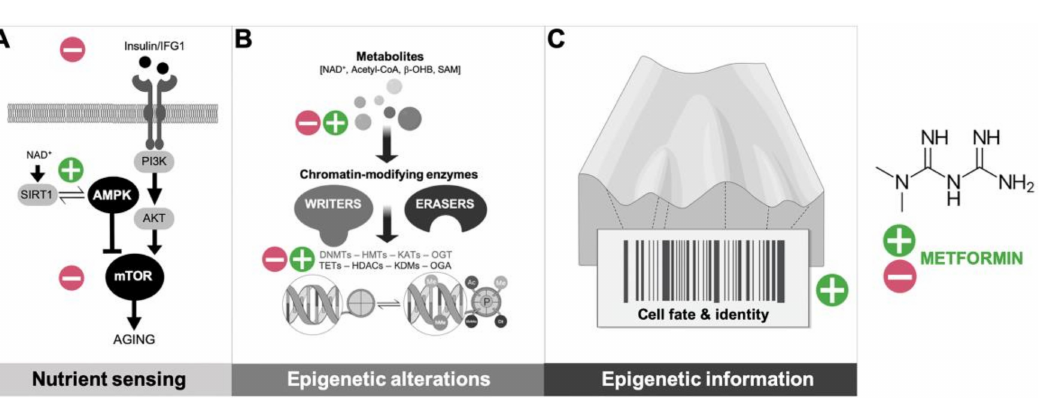
Figure 1. Anti-aging mechanisms of metformin: From metabolic controller of longevity to the sentinel of epigenetic information. ( A ) The insulin / insulin-like growth factor 1 (IGF-1) signaling pathway has prominent aging-modulating e ff ects, which are coupled with the activation status of central nutrient sensors such as sirtuins, AMP-activated protein kinase (AMPK), and mammalian Target Of Rapamycin (mTOR); the ability of metformin to block the insulin / IGF1 signaling while promoting proficient nutrient-sensing pathways (e.g., by activating Sirtuin-1 (SIRT1) and AMPK while suppressing mTOR) can promote organismal metabolic fitness to suppress aging-associated diseases. ( B ) Chromatin-modifying enzymes that catalyze aging-accompanying epigenetic alterations utilizes substrates and cofactors generated by intermediate metabolism; the ability of metformin to regulate